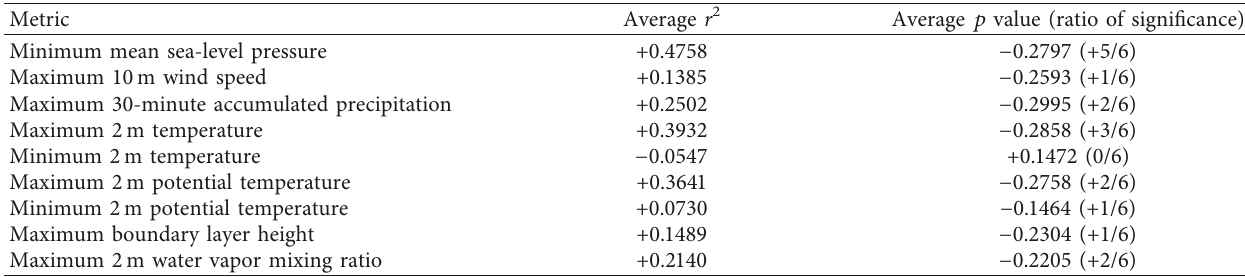
Table 5: Difference between the wind farm ensemble and stratospheric temperature perturbation ensemble in the average coefficient of determination ( r 2 ), average p value, and the ratio of significant cases for perturbations to midlatitude cyclones.